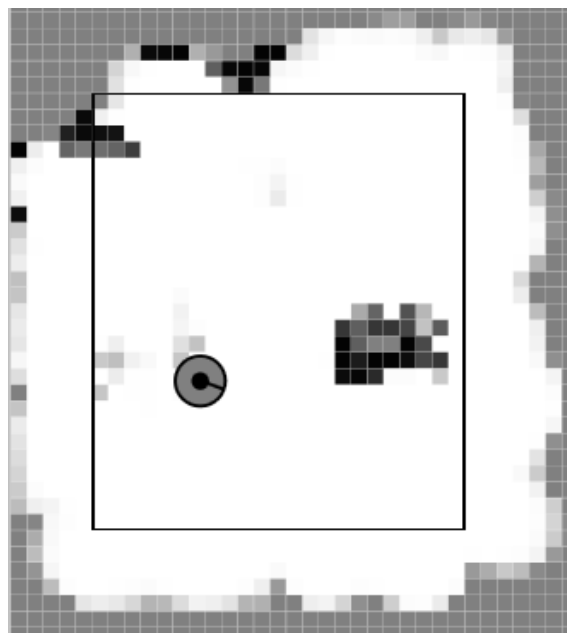
Fig. 10. The map of the environment modified by using the proposed mapping approach after removal of one